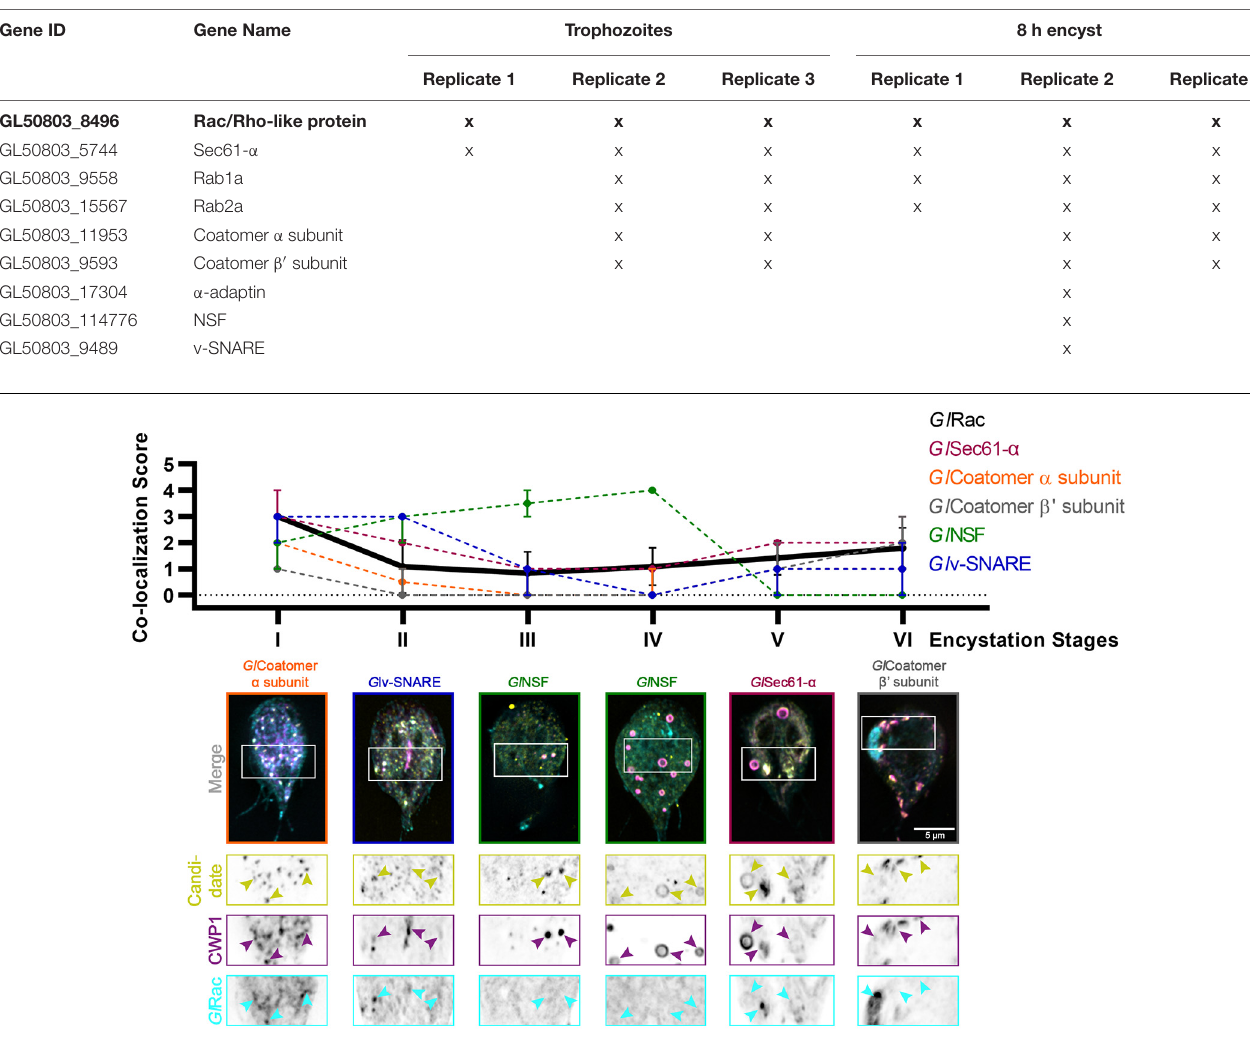
previously noted that Gl Rac associates with ESVs at